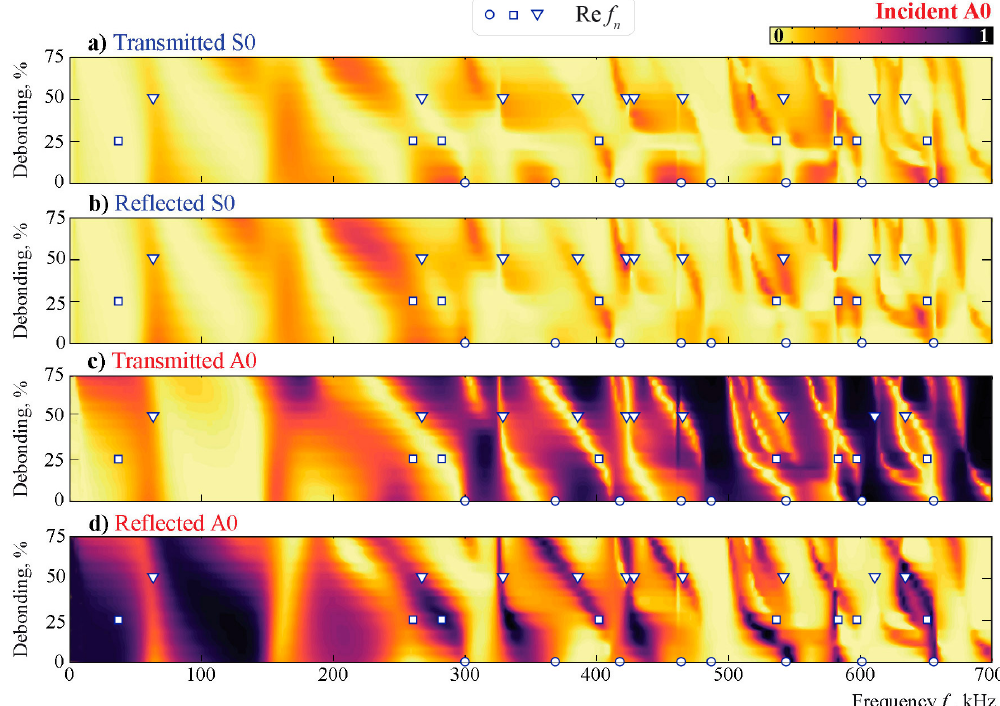
Figure 10. The transmission and reflection coefficients β ± m ( f , a ) for the incident A0 mode scattered by a debonded obstacle and the eigenfrequencies calculated for three different debonding